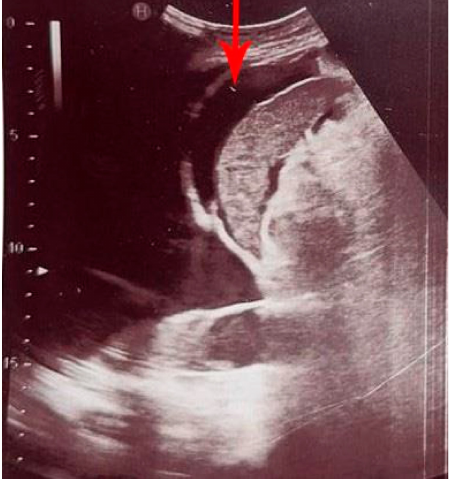
Figure 1. Peri-splenic intraperitoneal free fluid (IPF) (red